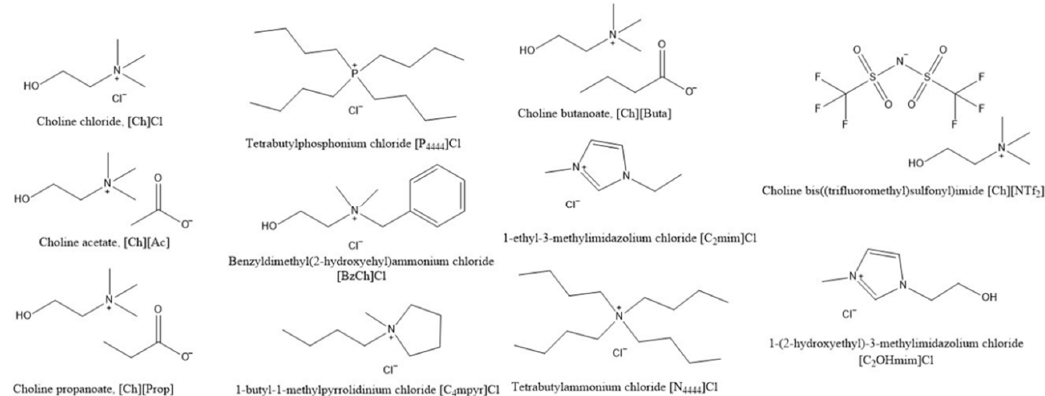
Figure 10. The activity coefficients of [Ch]Cl at the experimental eutectic point estimated assuming different melting enthalpies of [Ch]Cl. Figure 11. Chemical names and structures of the [Ch]Cl and ILs Figure 11. Chemical names and structures of the [Ch]Cl and ILs studied.